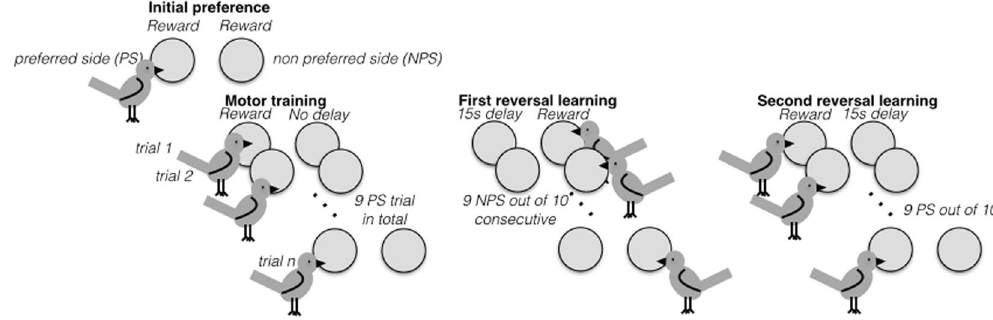
Figure 1. Graphical representation of the experimental protocol. In this example, the bird chooses the left side in the preference task and is then rewarded on the left side (preferred side) during the motor training phase. After a total of 9 correct trials of motor training, it starts the first reversal learning in which it is rewarded on the right side (non-preferred side) and punished on the left side. After reaching the learning criterion (9 correct response out of 10 consecutives trials), the bird then shifts to the second reversal in which it is rewarded on the left side and punished on the right side. Successive reversals are allowed to continue until 99 reversals in captivity and until 48 reversals in the wild. Artwork by M.